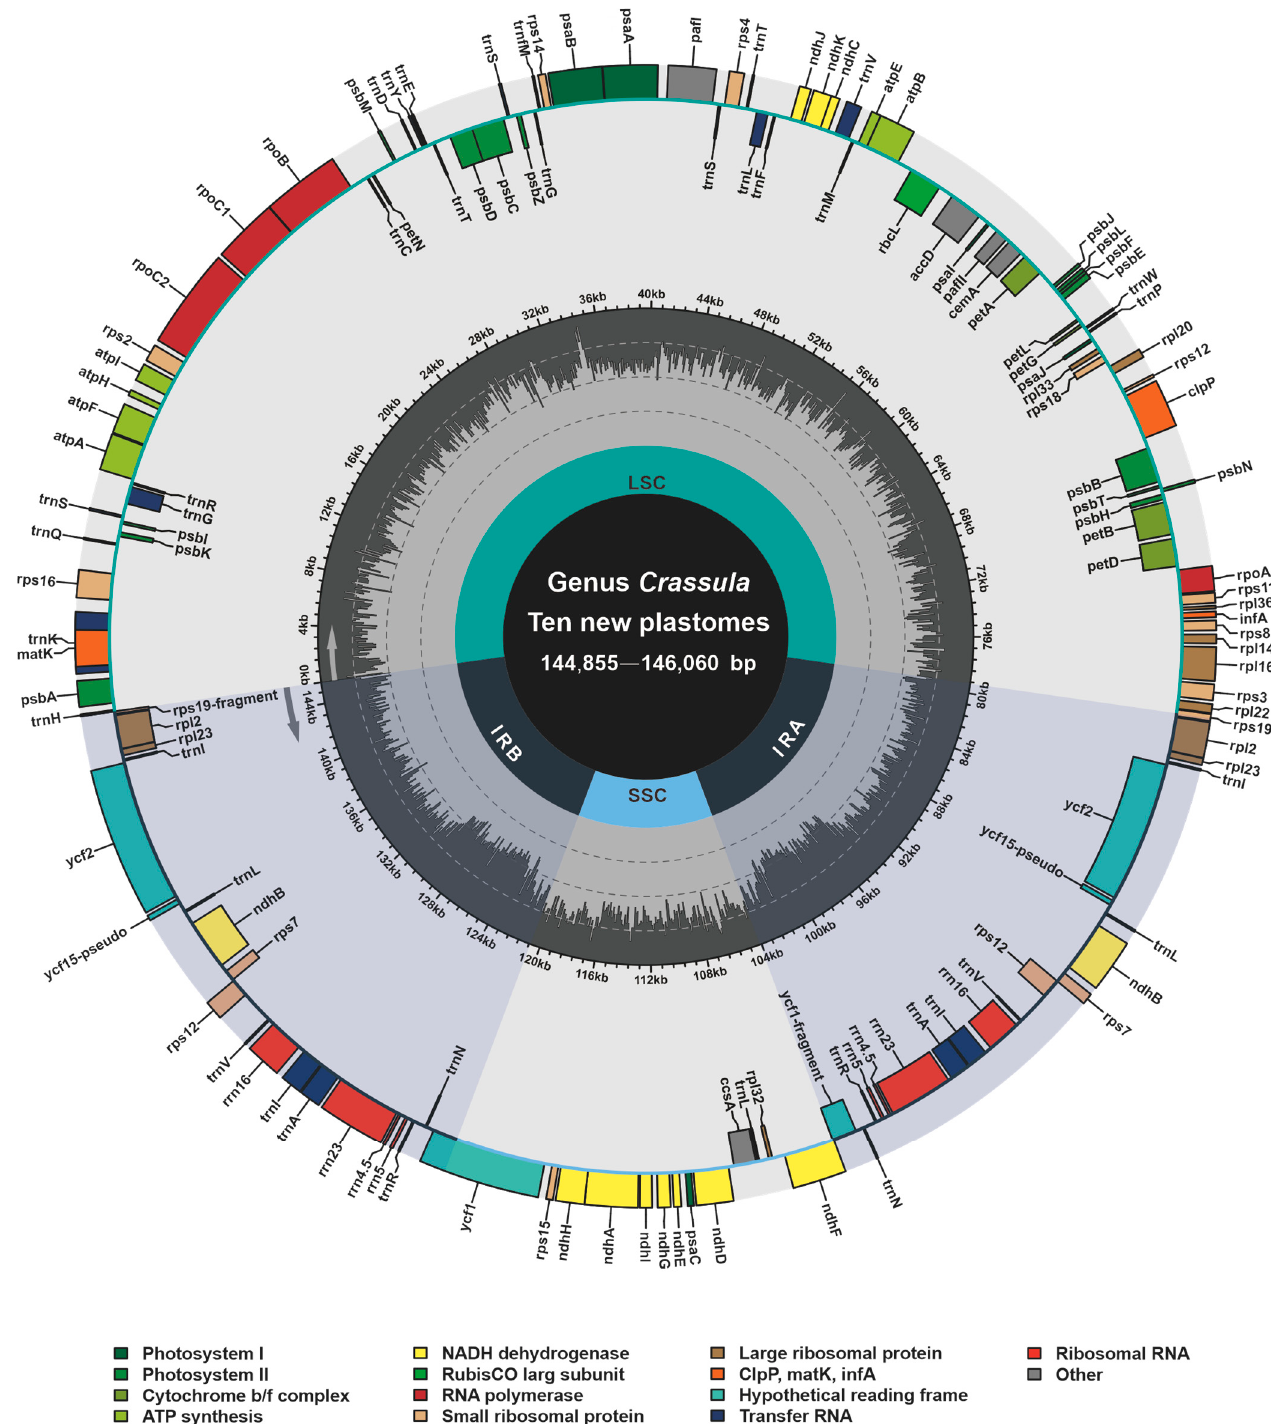
Figure 1. Annotation map of ten new plastomes from Crassula species. Directed with arrows, genes that are listed inside and outside of the circle are respectively transcribed clockwise and counterclockwise. Different colors represent different functional groups.